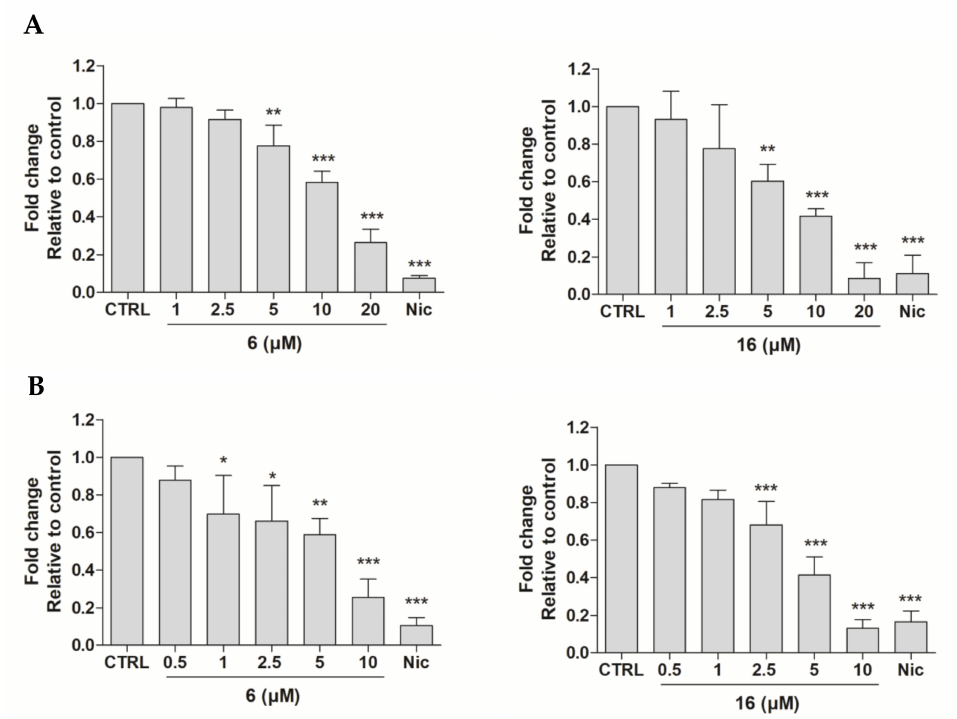
Figure 5. Compounds 6 and 16 reduced phosphorylation of STAT3 in human prostate cancer cells. DU145 cells were treated with both compounds at indicated concentrations for ( A ) 24 h and ( B ) 48 h. The levels of the phosphorylated form (p-STAT3 Tyr705 ) were detected by immunoblot analysis using an appropriate antibody. Samples treated with 5 µ M of niclosamide (Nic) for 24 h and 48 h were used as positive controls. Summary data of p-STAT3 Tyr705 levels, where the values shown are means ± SD of three independent experiments. The levels of p-STAT3 Tyr705 protein are expressed in relative units following normalization for the intensity of the corresponding β -actin bands. * p < 0.05, ** p < 0.01, *** p < 0.001, significantly different from drug-free